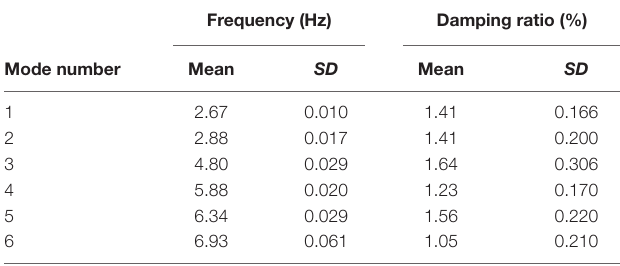
TABLE 1 | Statistics of identified frequency and damping ratio of the Baptistery San Giovanni. Frequency (Hz) Damping ratio